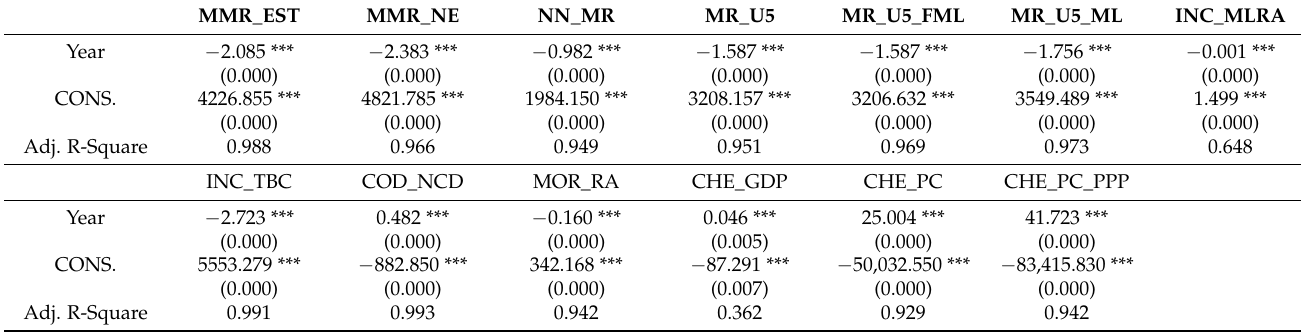
Table 5. Simple linear